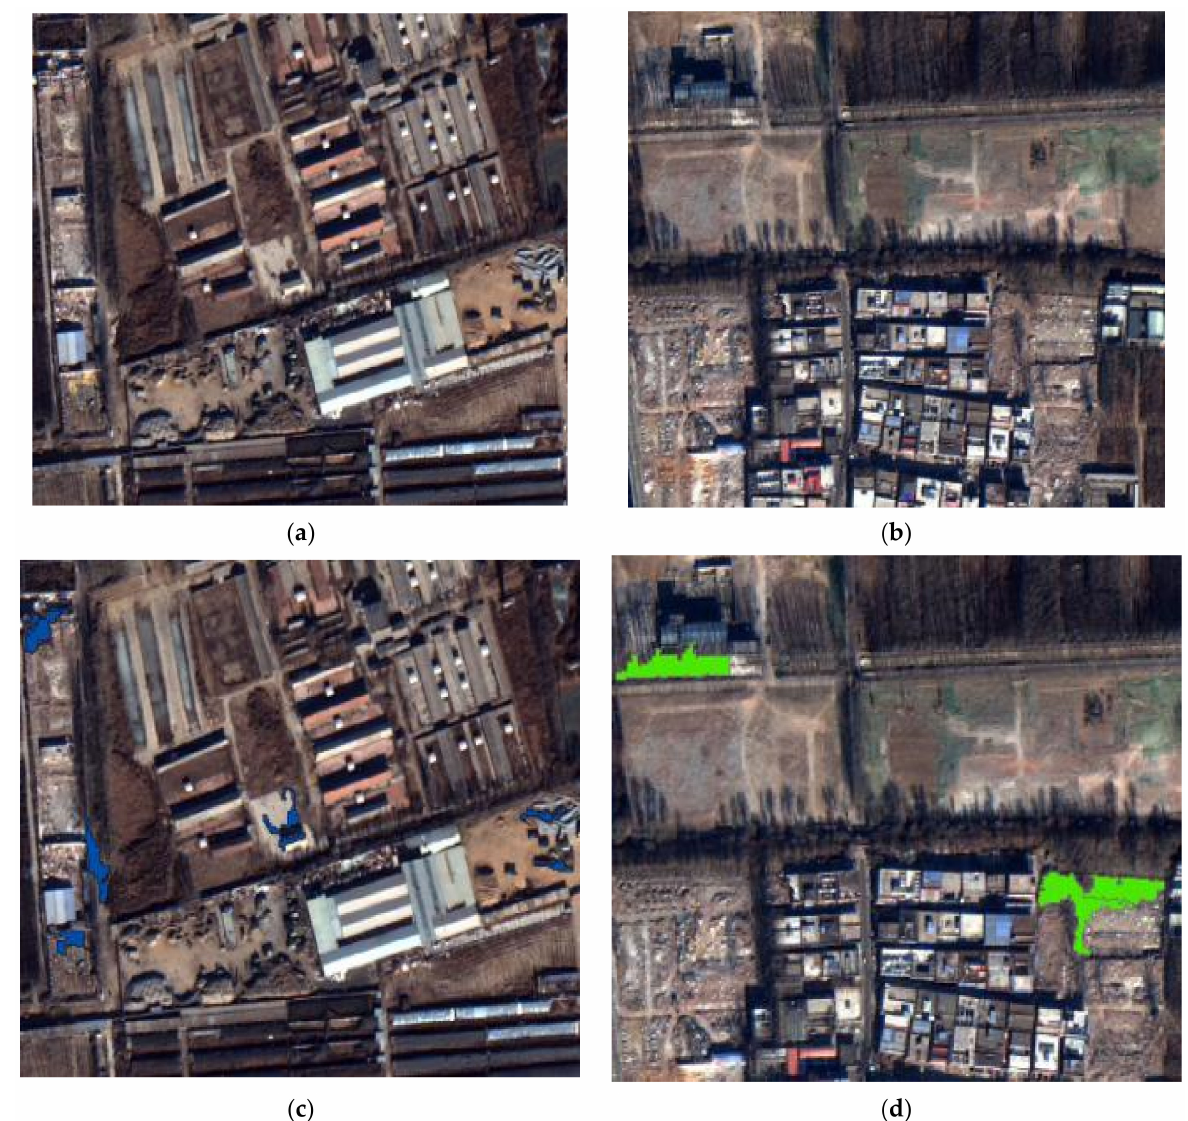
Figure 22. Classification results of the area and NDVI index: ( a , c ) the effect diagram of the area threshold and the original image, ( b , d ) s the original image and effect diagram of the vegetation area separated by the NDVI